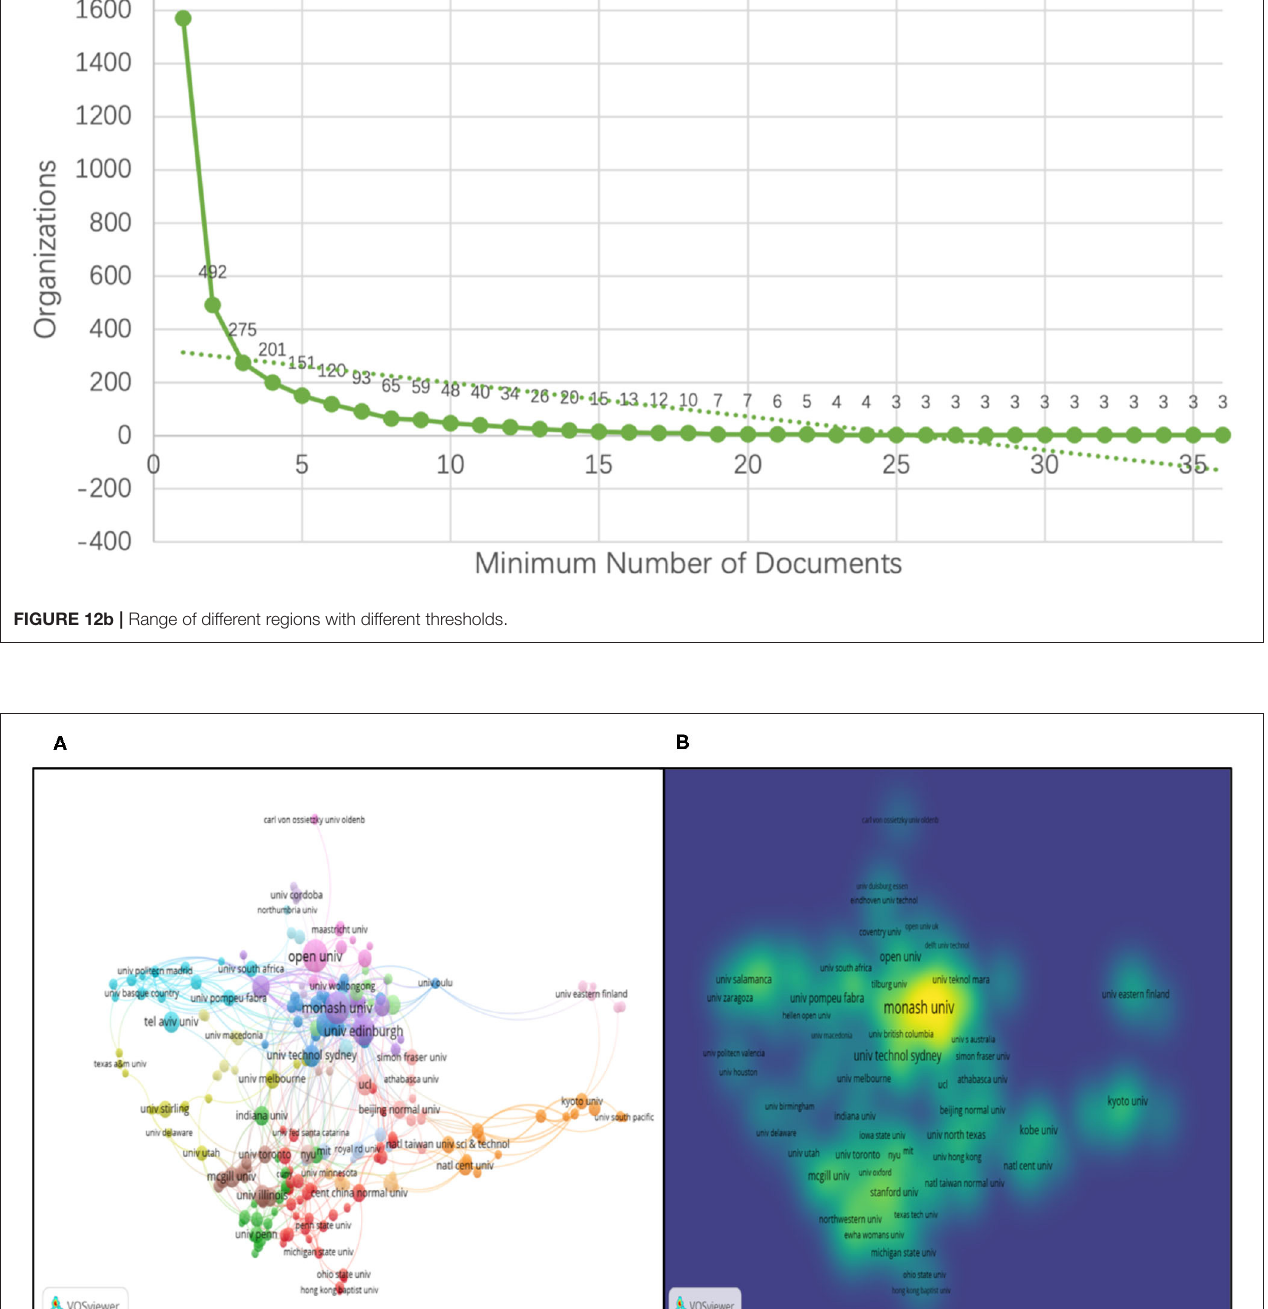
Frontiers in Psychology |